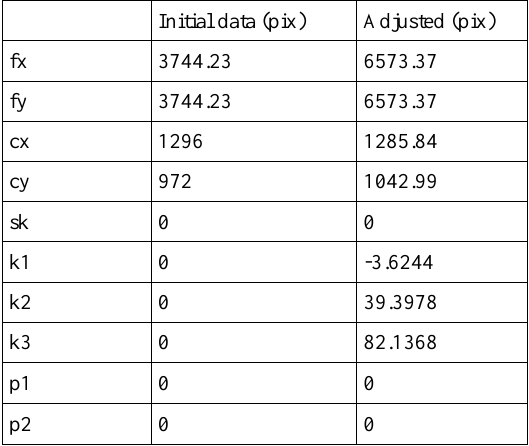
Table 9. GoPro calibration parameters